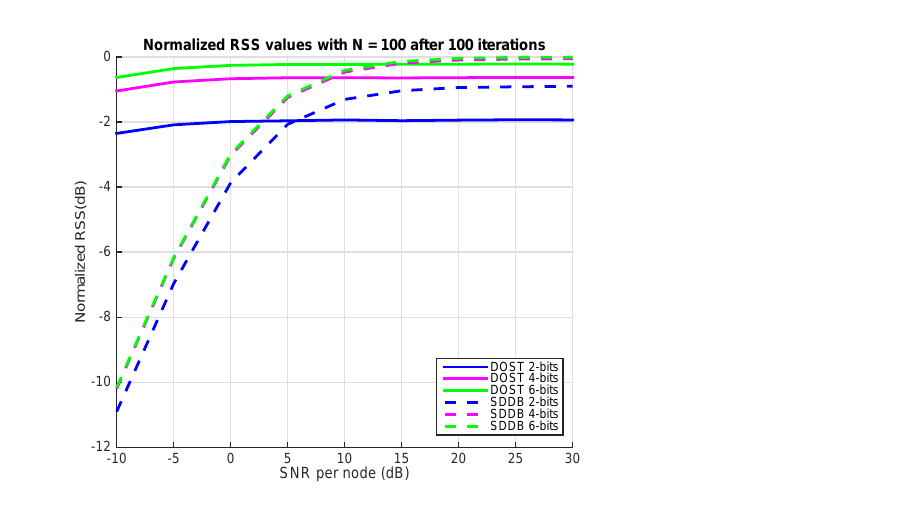
Figure 4. Beamforming gains for SDDB and DOST for different number of feedback bits normalized to the optimal beamforming gain, N